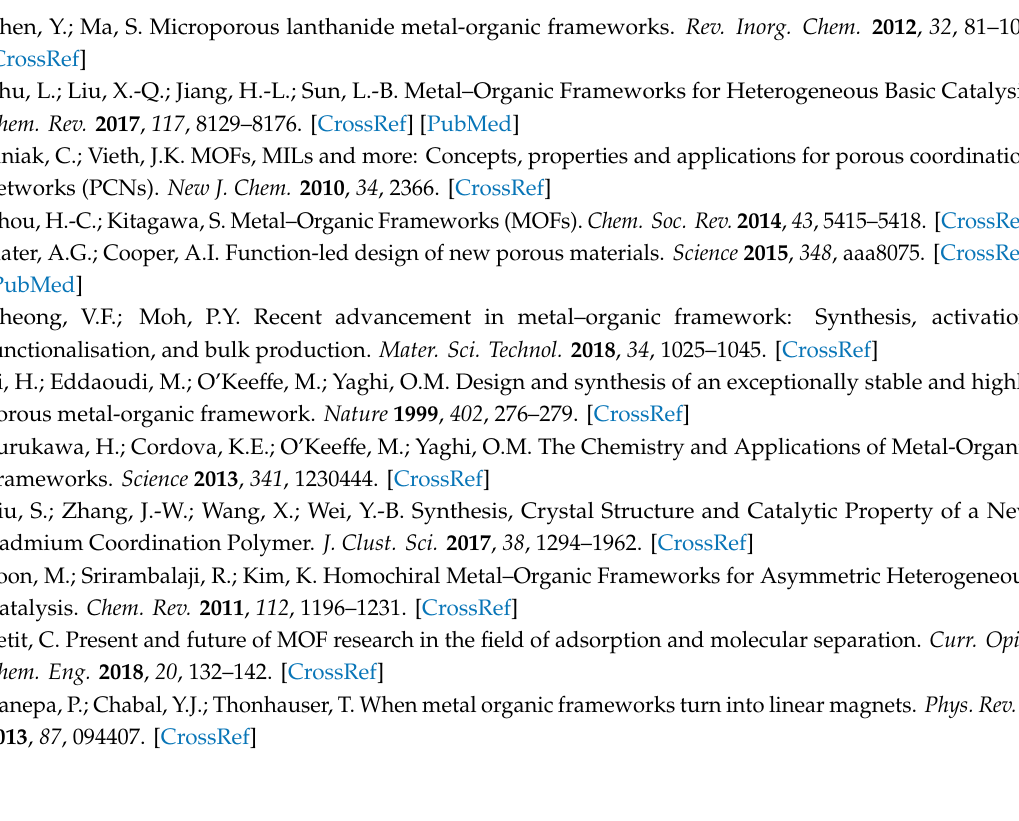
( 2 ). Figure S24: Thermogravimetric analysis of compound [NdL(H 2 O) 2 ] n · 1.33DMF · 2H 2 O ( 3 ). Figure S25: Thermogravimetric analysis of compound [EuL(H 2 O) 2 ] n · 1.33DMF · 2H 2 O ( 4 ). Figure S26: Thermogravimetric analysis of compound [GdL(H 2 O) 2 ] n · 2DMF · 2H 2 O ( 5 ). Figure S27: Thermogravimetric analysis of compound